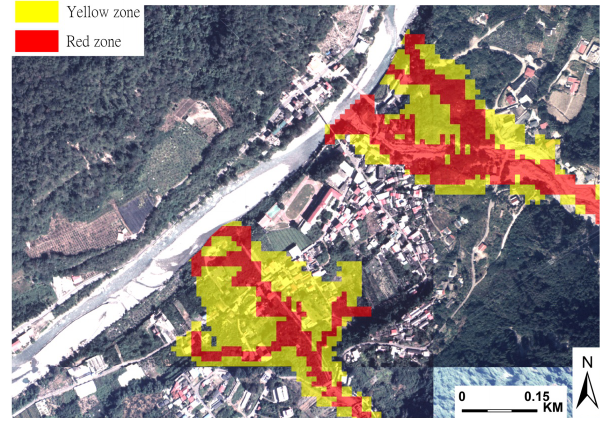
Fig. 1. Locations of two debris flow torrents in the Songhe community. Destruction caused by Typhoon Mindulle in 2004 is shown in the photograph.